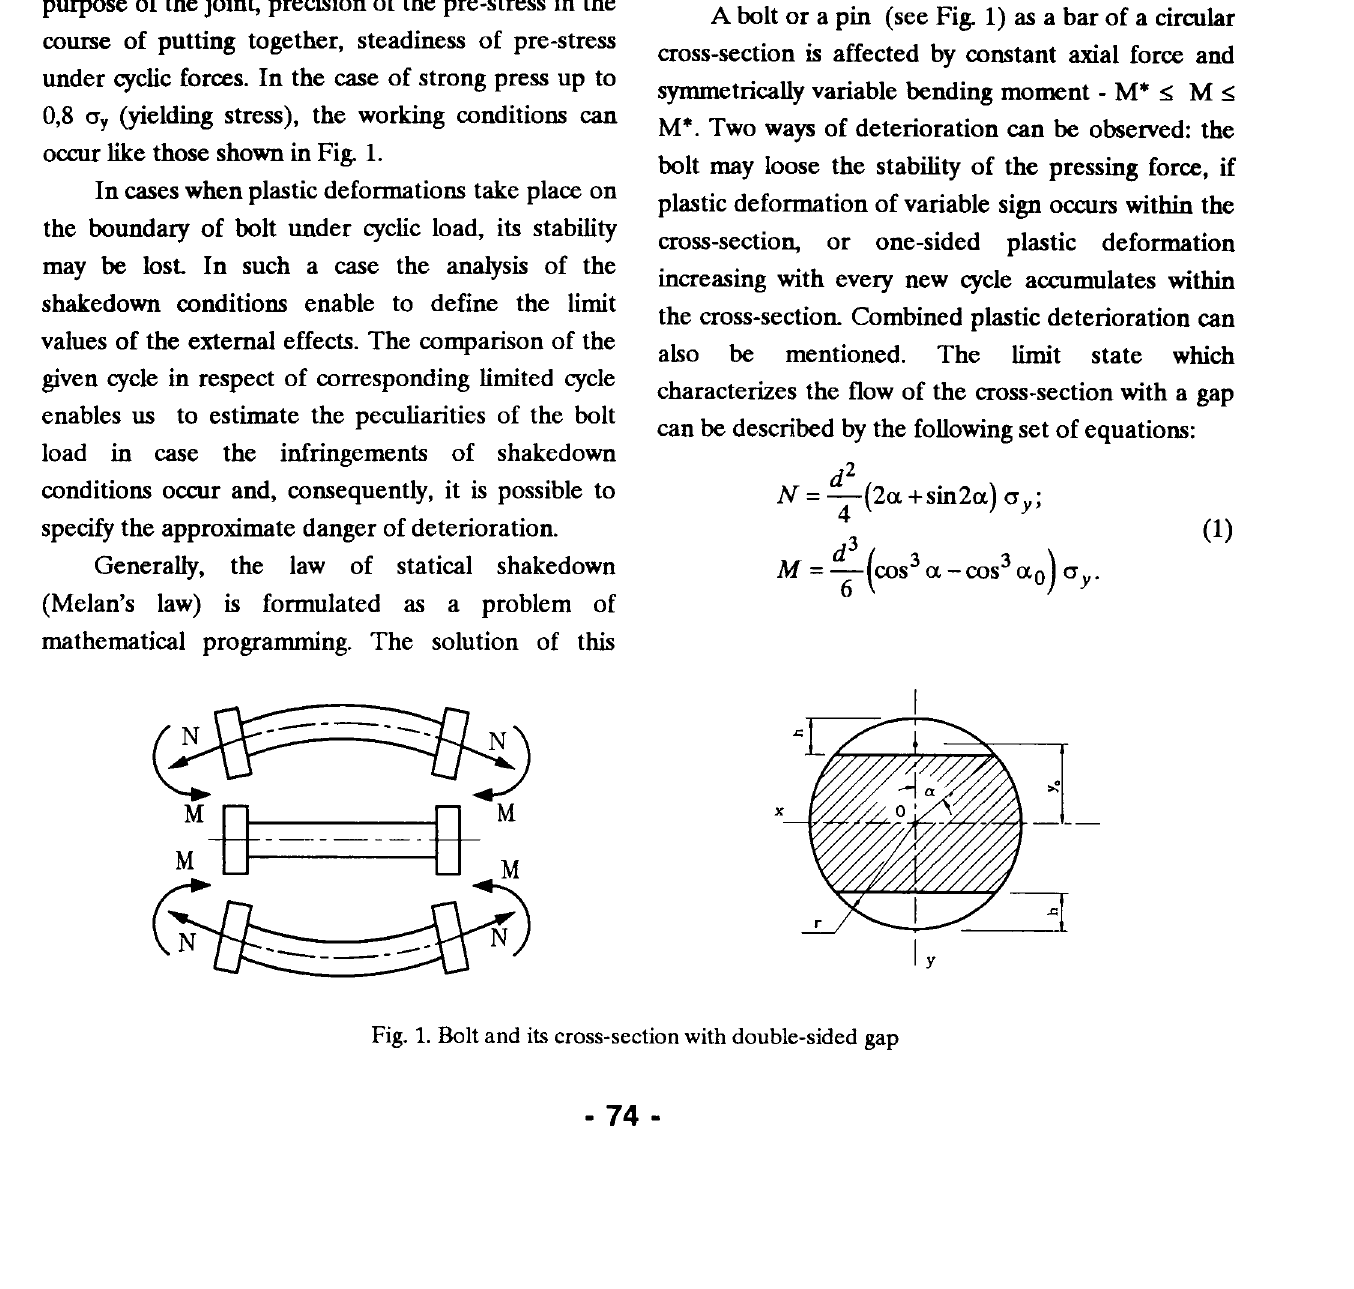
Fig. 1. Bolt and its cross-section with double-sided gap .